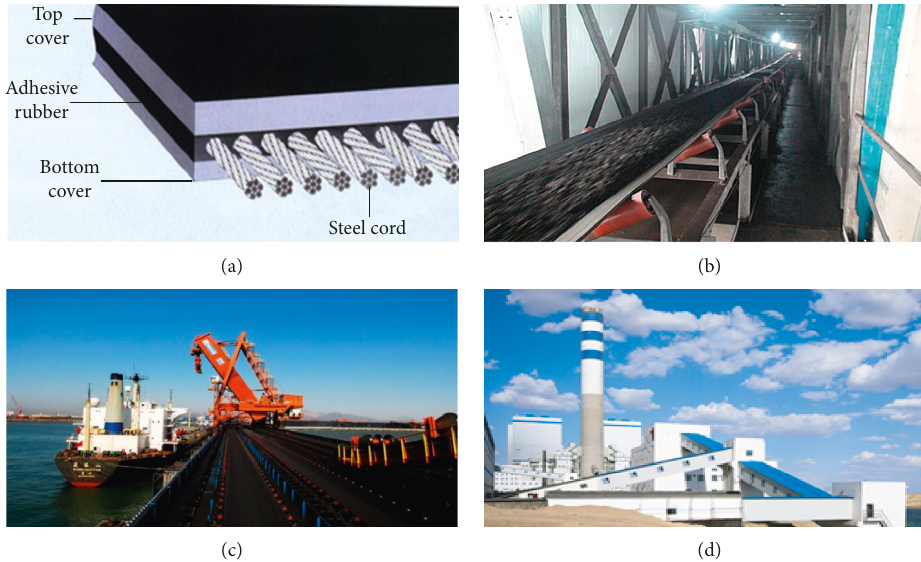
Figure 1: (a) Structure of the conveyor belt and application fields of the conveyors: (b) mining, (c) port, and (d) electric power.